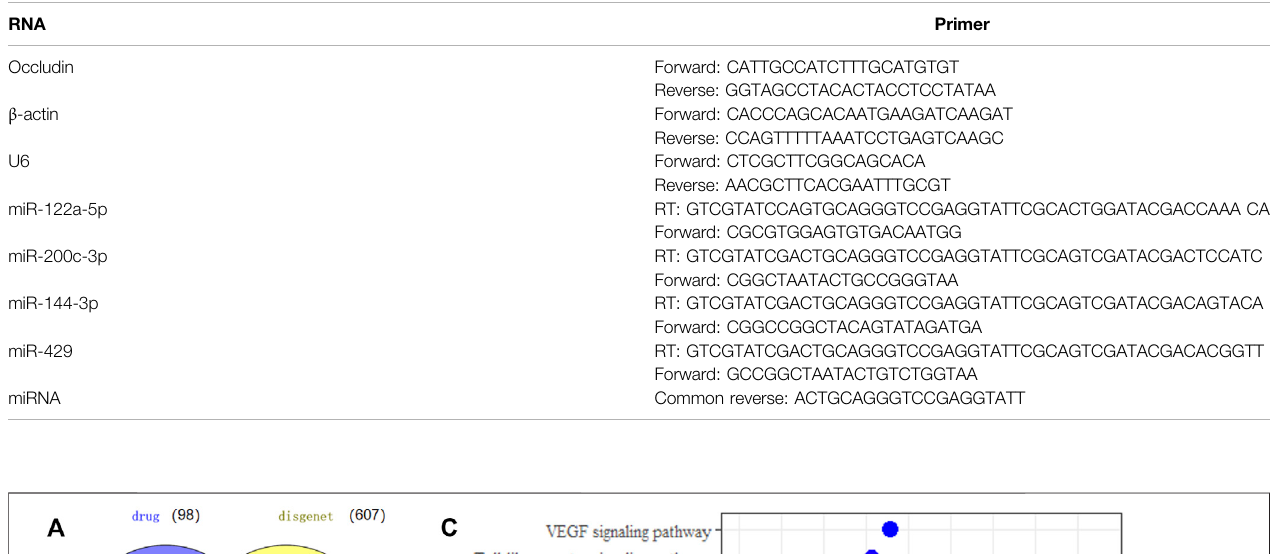
TABLE 1 | This is a table. Reverse transcription (RT).